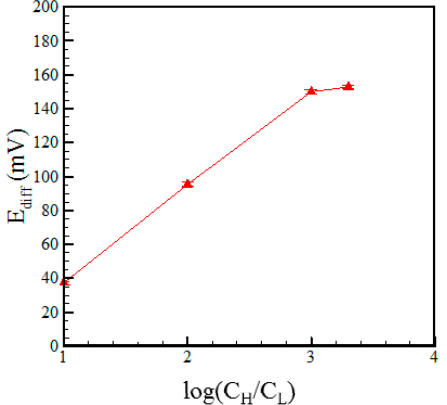
Figure 5. Variation of diffusion potential with concentration ratio given microchannel length of 1 mm.